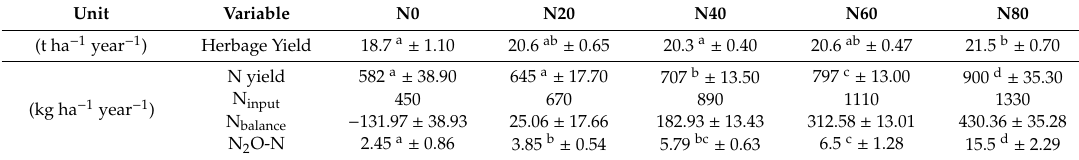
Table 3. Means ( ± standard error) of herbage yield, N-yield, N input , N balance , and measured annual N 2 O-N emissions. The N0, N20, N40, N60, and N80 refer to the fertilizer rates used as treatments and were 0, 220, 440, 660, and 880 kg N ha − 1 year − 1 , respectively. N input and N balance were calculated using Equations (3) and (4) and were not independent from treatments, and therefore not subjected to statistical analysis. Means in the same row with no common superscript di ff ered significantly ( p < 0.05). Unit Variable N0 N20